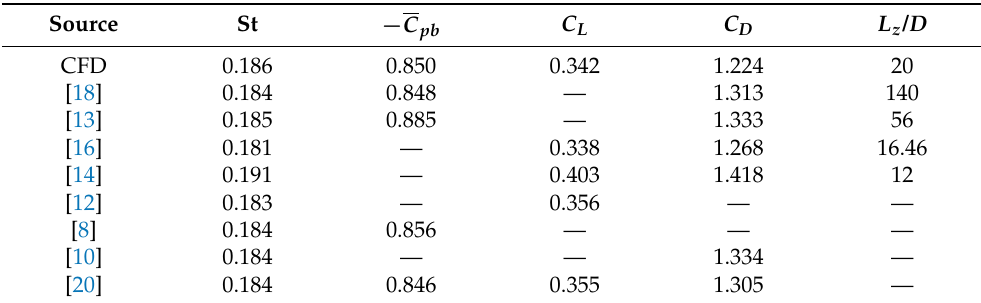
Table 1. Comparison of calculated data with available numerical and experimental results (for Re = 150).